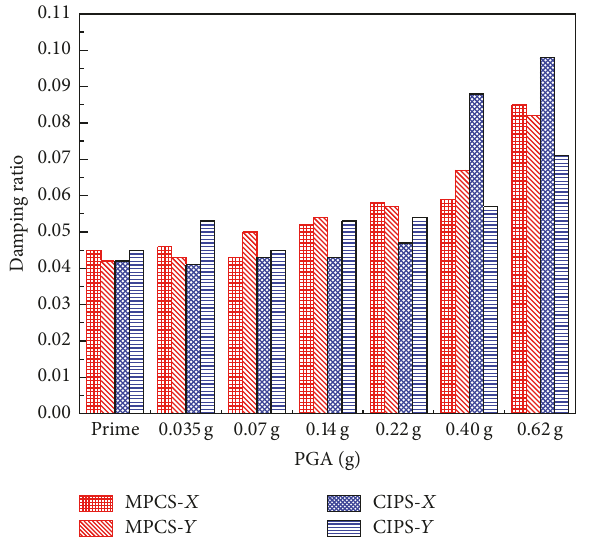
Figure 8: Damping ratios of CIPS and